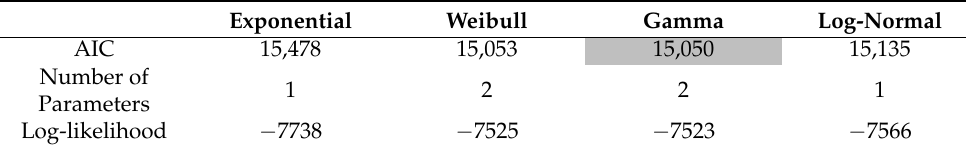
Table 9. AIC values for possible distributions of equalization reserves (non-life). Exponential Weibull Gamma Log-Normal AIC 15,478 Number of 1 2 2 1 Parameters Log-likelihood − 7738 − 7525 − 7523 − 7566